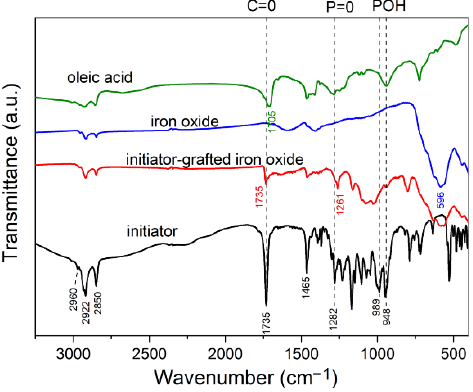
Figure 5. FTIR spectrum of initiator-modified iron oxide (red), compared to spectra of oleic acid (green), iron oxide (blue), and initiator (black).